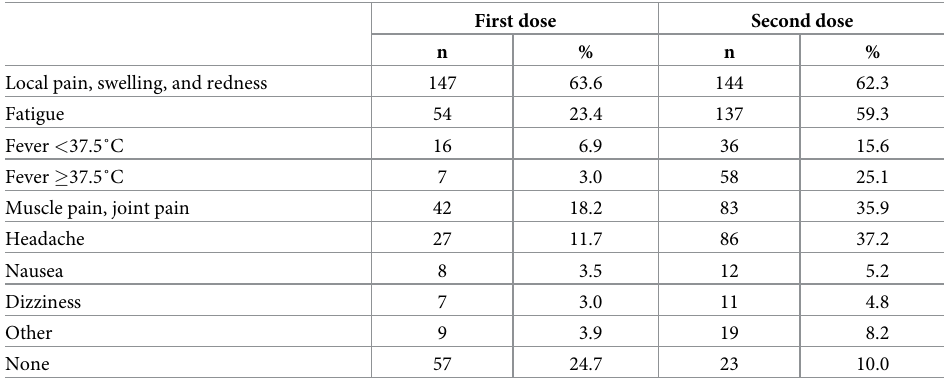
Table 2. Adverse